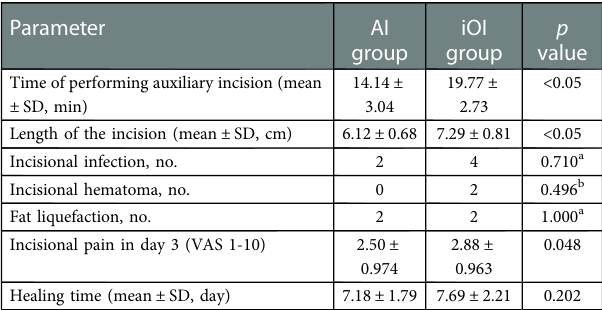
TABLE 3 Comparison of incisional outcomes between